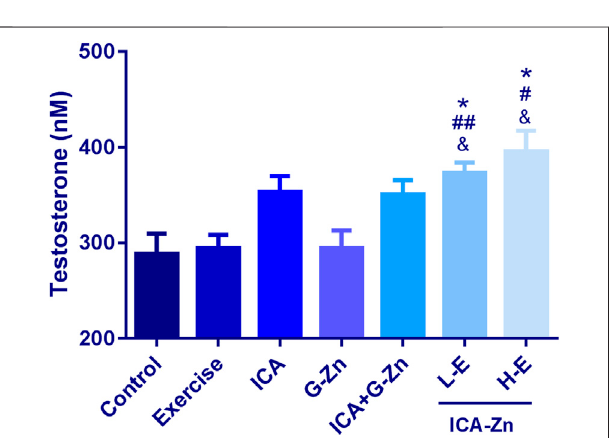
FIGURE 12 | Effect of exercise and icariin-zinc on the plasma testosterone content of rats ( n (cid:2) 8, mean ± SD). *p < 0.05 vs.